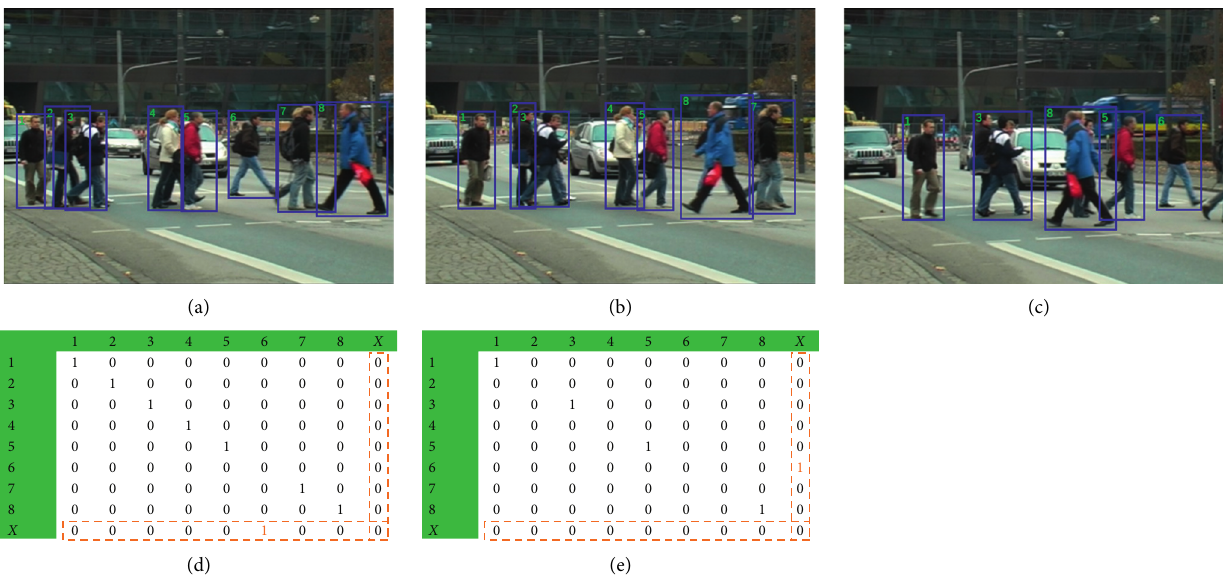
Figure 3: Frame comparison. From: TUD-Crossing-test (frame: 1, 13, and 26). (a) Frame 1. (b) Frame 13. (c) Frame 26. (d) Matrix with dummy boxes (1 and 13). (e) Matrix with dummy boxes (13 and